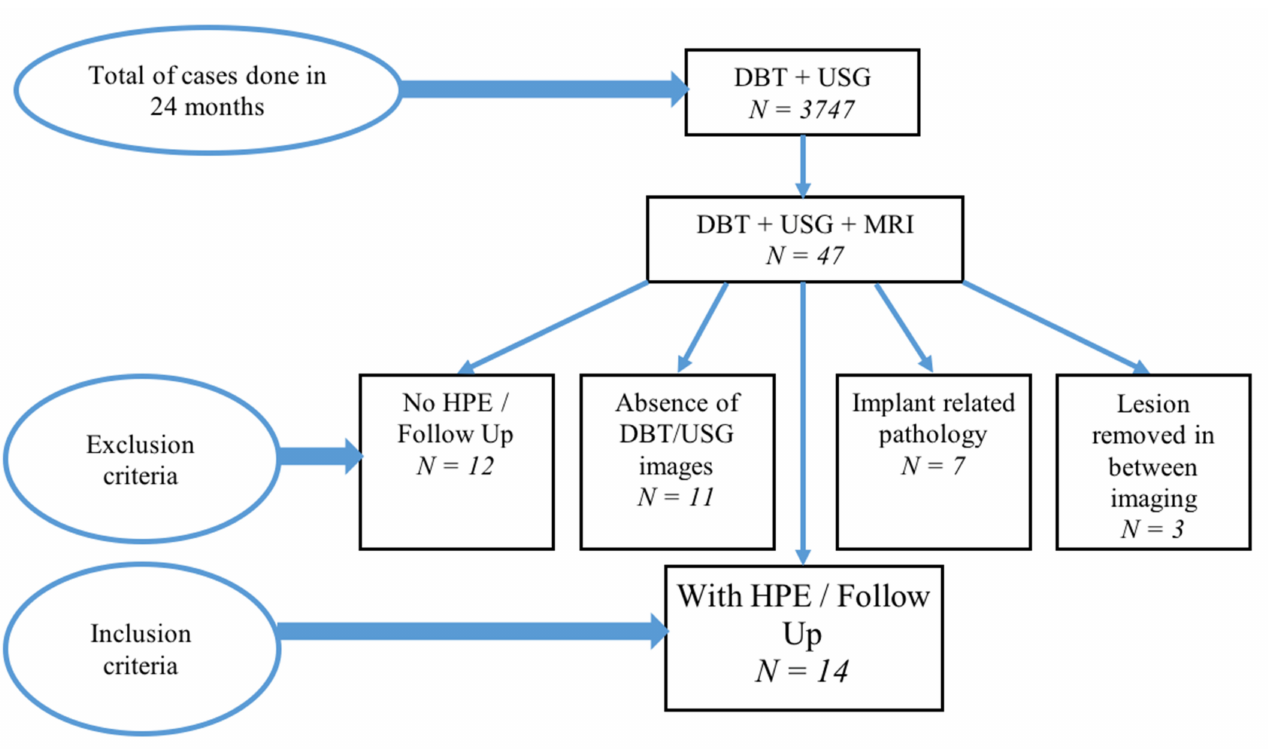
Figure 1. Patient selection in present